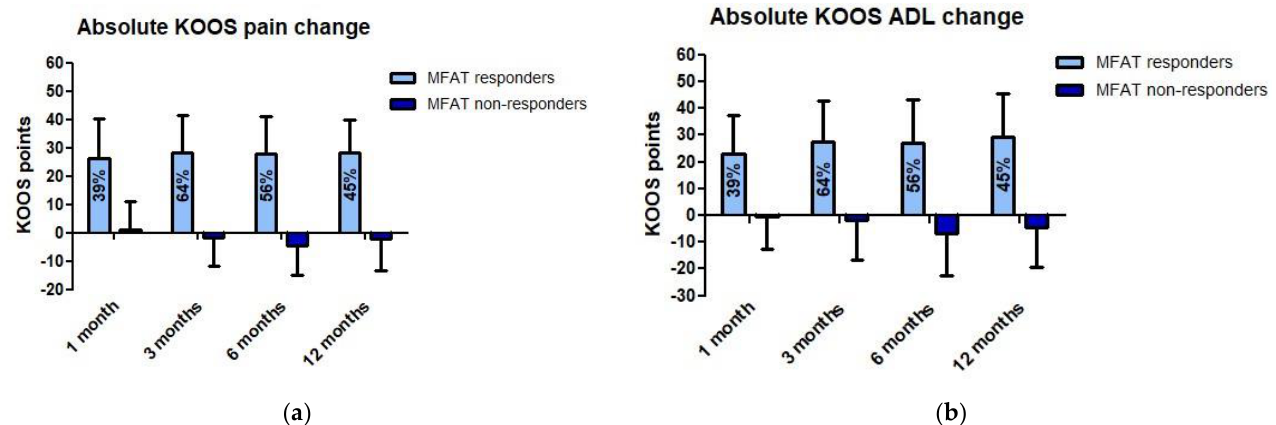
Figure 4. Overall therapeutic response rate (TRR) and associated absolute change in ( a ) KOOS pain and ( b ) KOOS activities of daily living (ADL) relative to baseline.